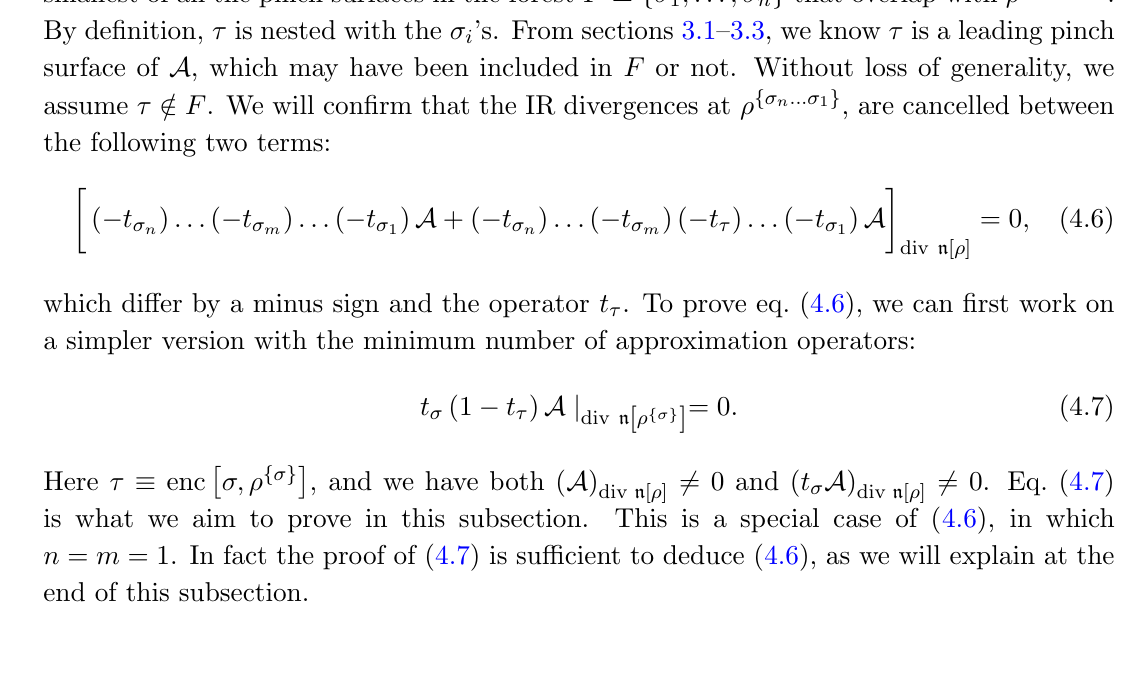
( m 6 p 6 n ) reside in the soft and jet subgraphs, p (1 6 q 6 m ) reside in the jet q